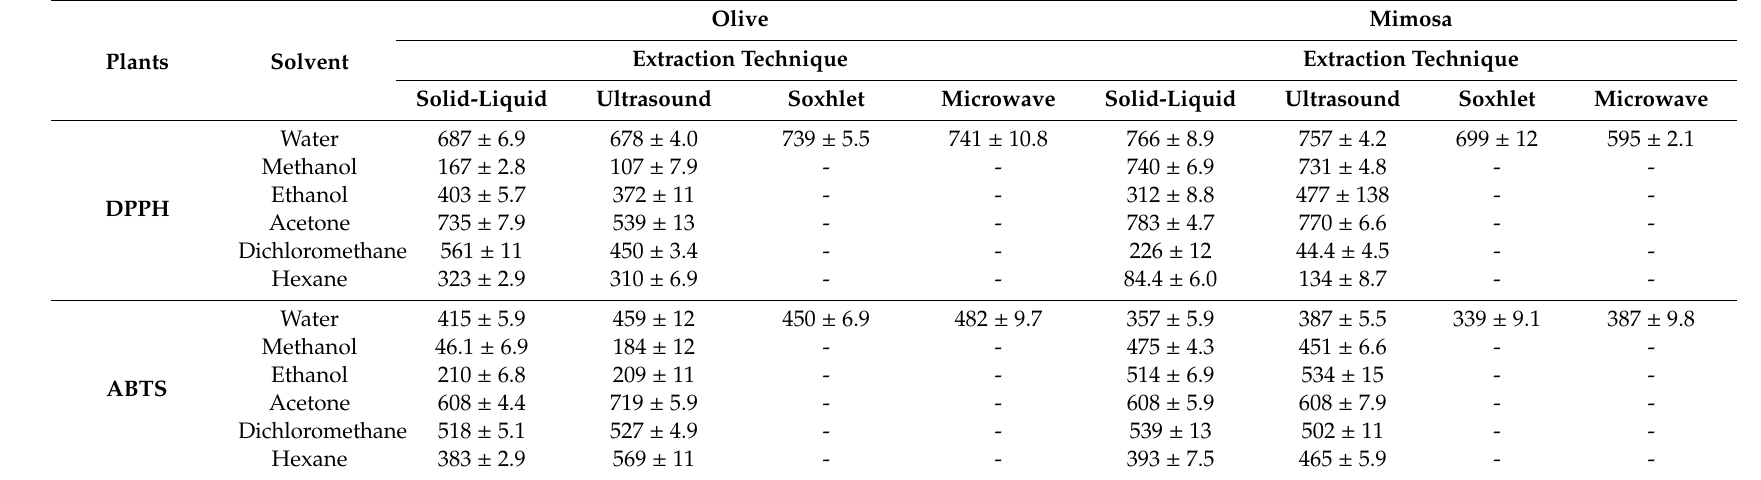
Table 4. Antioxidant capacity assessed by DPPH (2,2-diphenyl-1-picrylhydrazyl) and ABTS (2,2-azinobis (3-ethyl-benzothiazoline-6-sulfonic acid)) assays of olive and mimosa leaf crude extracts at 5 mg / mL obtained with the di ff erent extraction techniques and the selected solvents (expressed in TE / g fresh